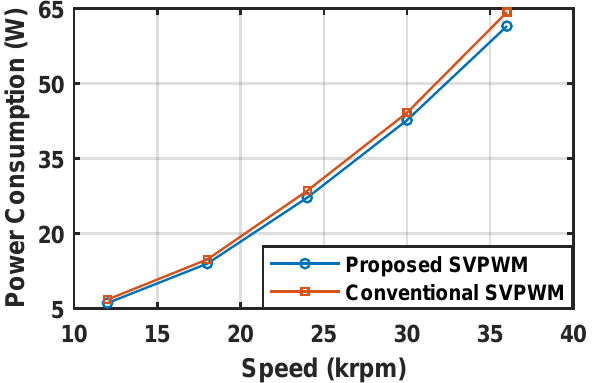
Figure 21. The maintenance speed power consumption of the proposed and conventional SVPWM